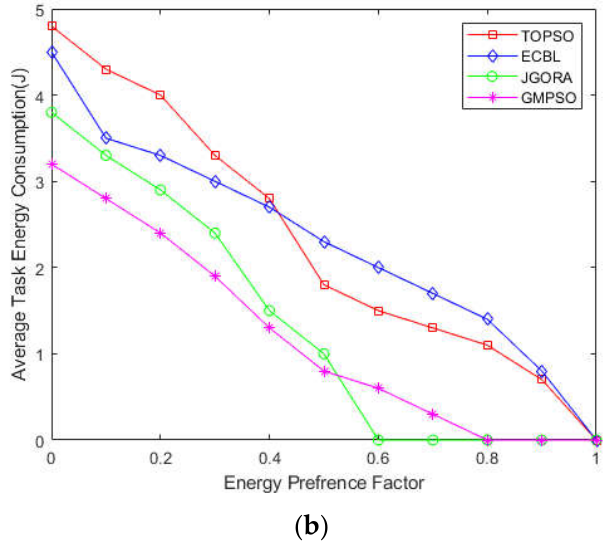
Figure 8. Delay and energy consumption versus weighting factors: ( a ) Average task latency at different β t n ; ( b ) Average task energy consumption at different β e n .